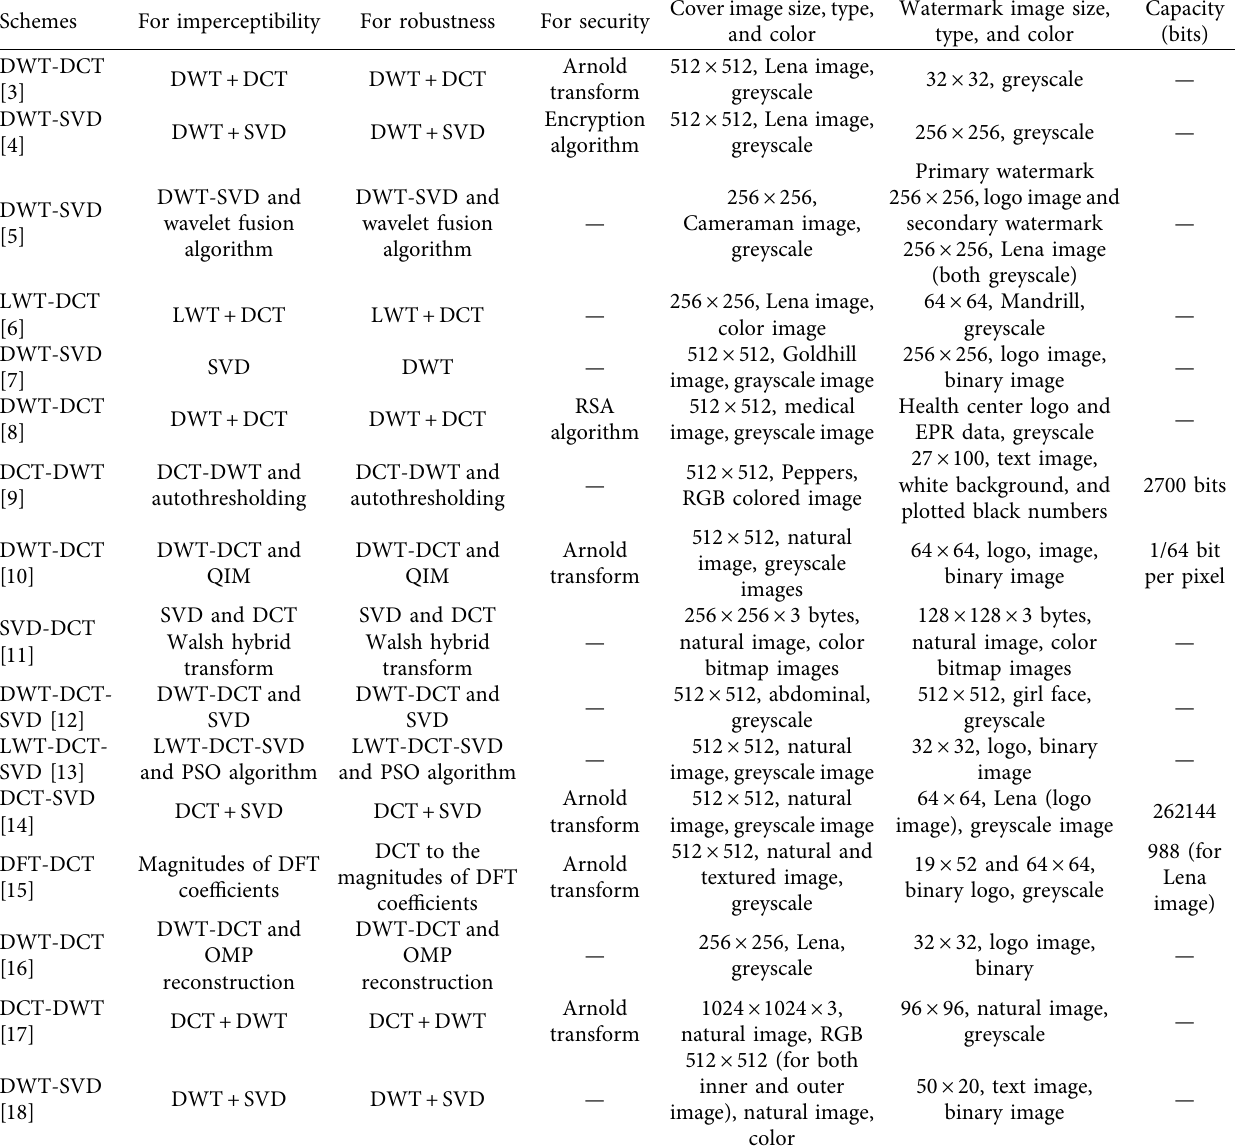
Table 1: Summary of the state-of-the-art hybrid methods.